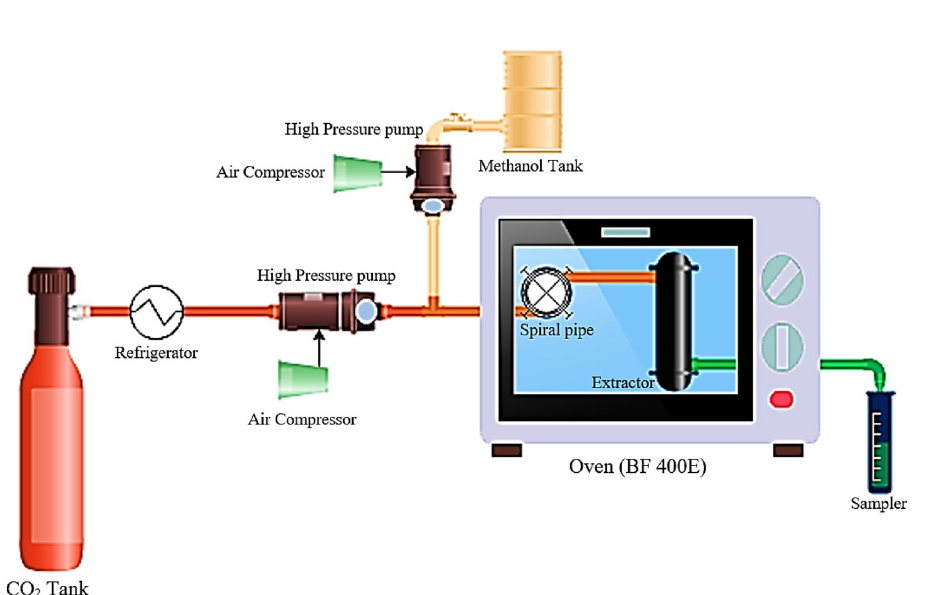
Figure 1. The setup shown schematic diagram of the experimental setup used for measuring